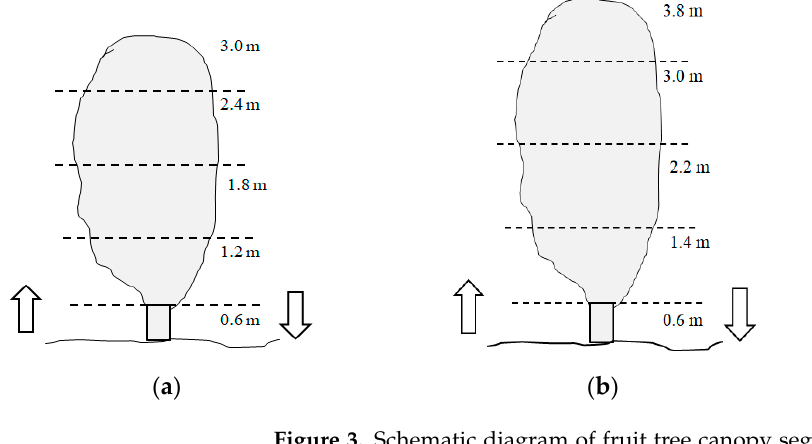
Table 2. Meteorological conditions during spraying in the field